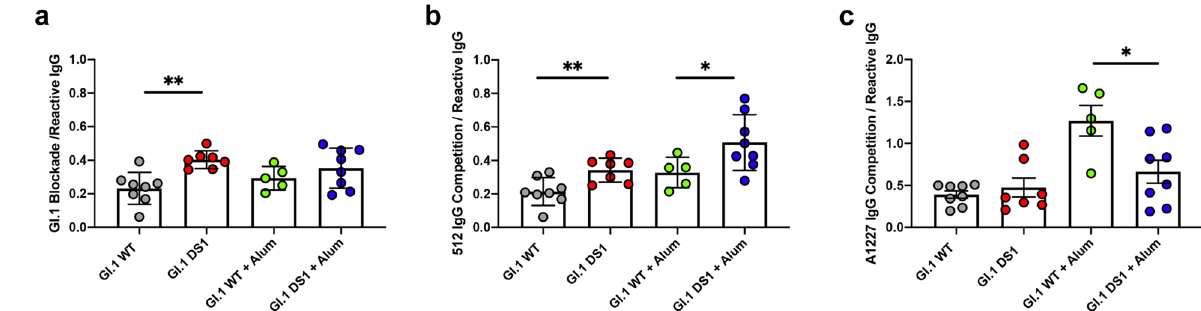
Fig. 6 Stabilization of GI.1 VLPs focuses immune responses toward blockade epitopes and away from occluded epitopes. a Ratio of blockade titers over total GI.1-reactive IgG titers at week 22. In the absence of alum, immunization with GI.1 DS1 leads to a twofold increase in blockade titers relative to total GI.1-reactive titers, compared to immunization with GI.1 WT. b Ability of serum antibodies at week 22 to compete with blockade antibody 512, relative to total GI.1-reactive titers. For both non-adjuvanted and adjuvanted groups, sera from mice immunized with stabilized VLP can compete with 512 binding more than sera from mice immunized with wild-type VLPs. c Ability of serum antibodies at week 22 to compete with occluded-site antibody A1227, relative to total GI.1-reactive titers. In the presence of alum, sera from mice immunized with wild-type VLPs can compete with A1227 more than sera from immunization with stabilized VLPs. Mean ± SD are shown in each box plot. P values were determined by two-tailed Mann – Whitney tests. * P ≤ 0.05, ** P ≤